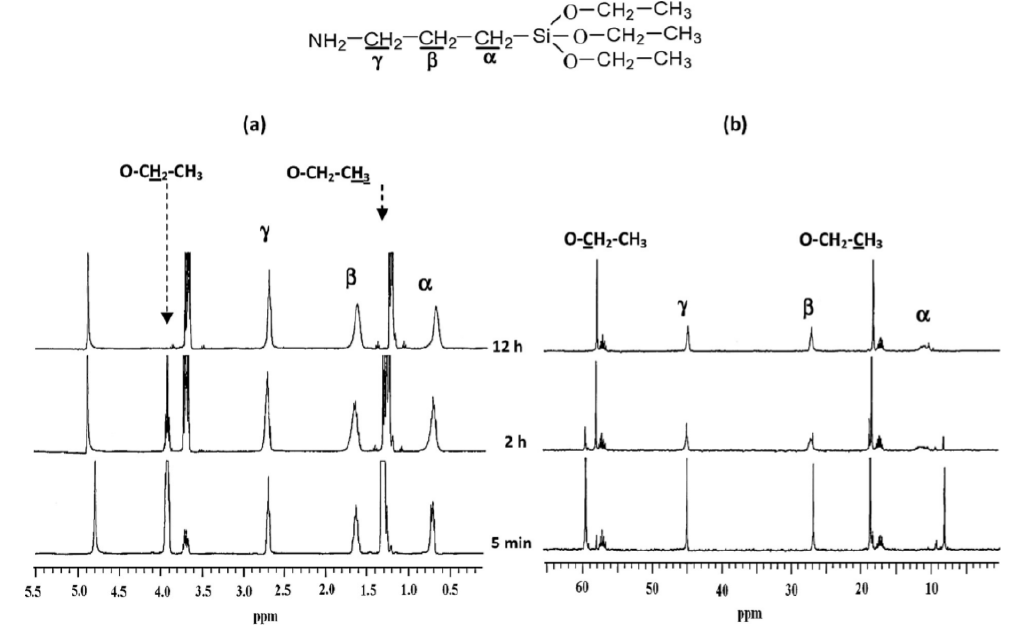
Figure 22. ( a ) 1 H and ( b ) 13 C NMR spectra of γ -aminotriethoxysilane (APS) hydrolysis ( t = 5 min and t = 4 h) under natural pH. Reprinted with permission from [49]. Copyright Elsevier, 2013. Table 5. The chemical shifts from the Q-species (hydrolyzed monomers and oligomers) of TEOS and TMOS. Here, the Q represents the quaternary functional silanes. Reprinted with permission from [4]. Copyright Elsevier, 1990.